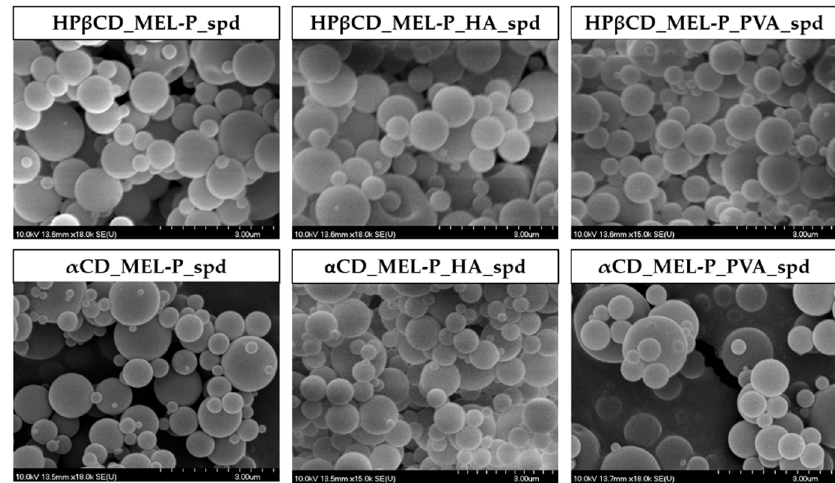
Figure 3. SEM images of the spray dried samples. The scale bar = 3.0 µ m. Table 2. Average particle size (PS).